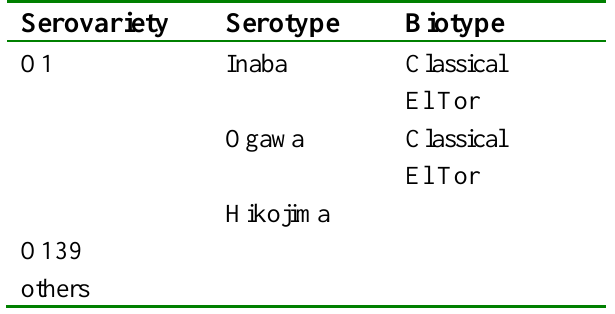
Table 3. Subdivision of Vibrio cholerae below the species level a